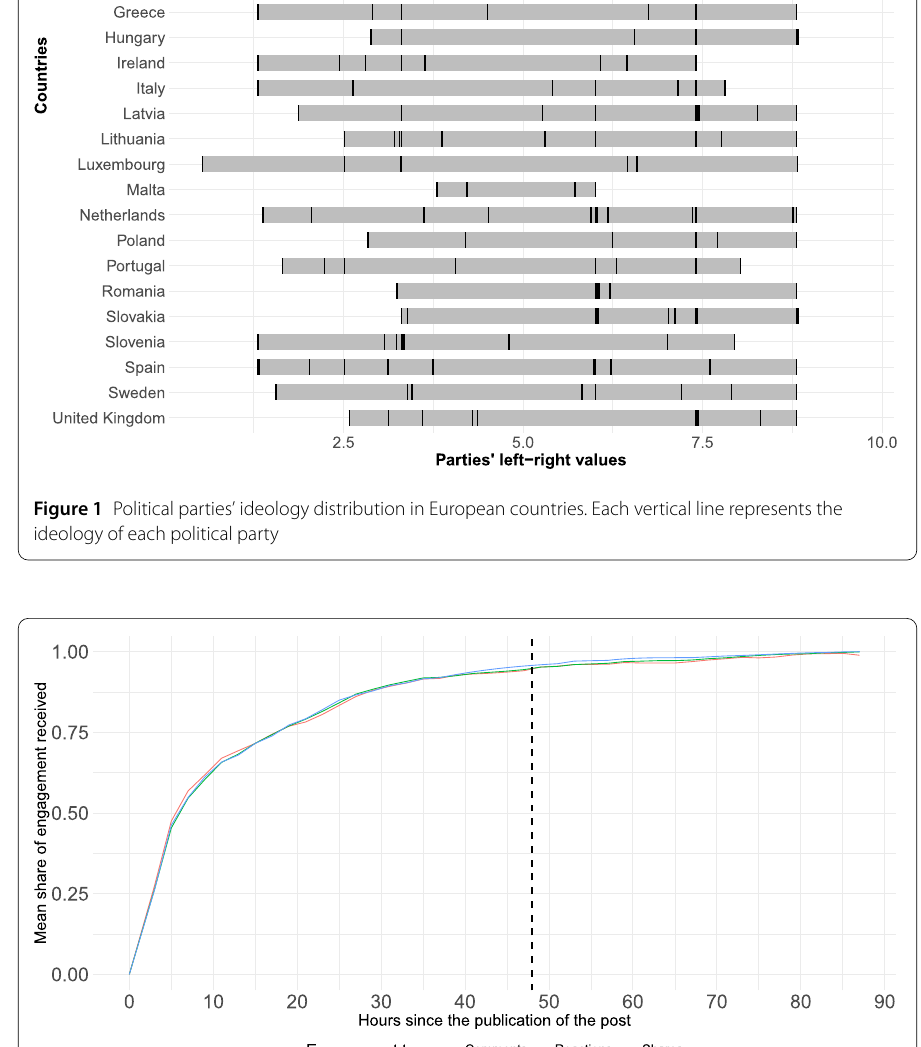
ative analysis of the activity of the EU + UK political parties on Facebook. We look into four specific elements: (i) activity overtime referred to as temporal analysis ; (ii) activity across countries referred to as inter-country analysis ; (iii) activity across political parties within the same country referred to as intra-country analysis ; and, (iv) activity per